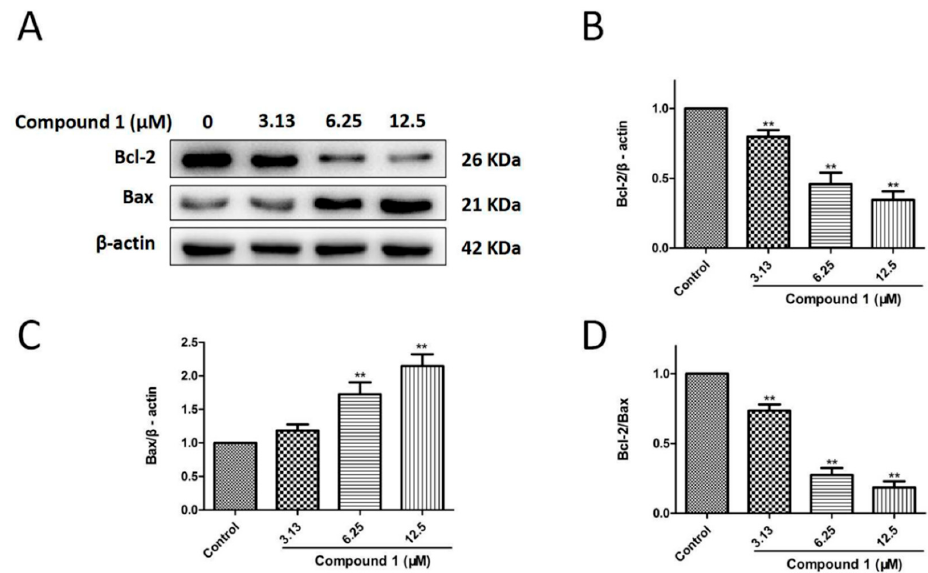
Figure 7. Effects of compound 1 on Bcl-2 and Bax expression in A549 cells. ( A ) Bcl-2 and Bax protein levels were detected by an immunoblotting experiment. ( B ) Compound 1 at concentrations of 3.13, 6.25, and 12.5 µ M significantly decreased the expression level of Bcl-2. ( C ) Compound 1 at concen- trations of 6.25 and 12.5 µ M significantly increased the expression level of Bax. ( D ) Compound 1 at concentrations of 3.13, 6.25, and 12.5 µ M dramatically reduced the Bcl-2/Bax ratio. Data are shown as the mean ± SD ( n = 3). ** p < 0.01 in comparison with the control group.